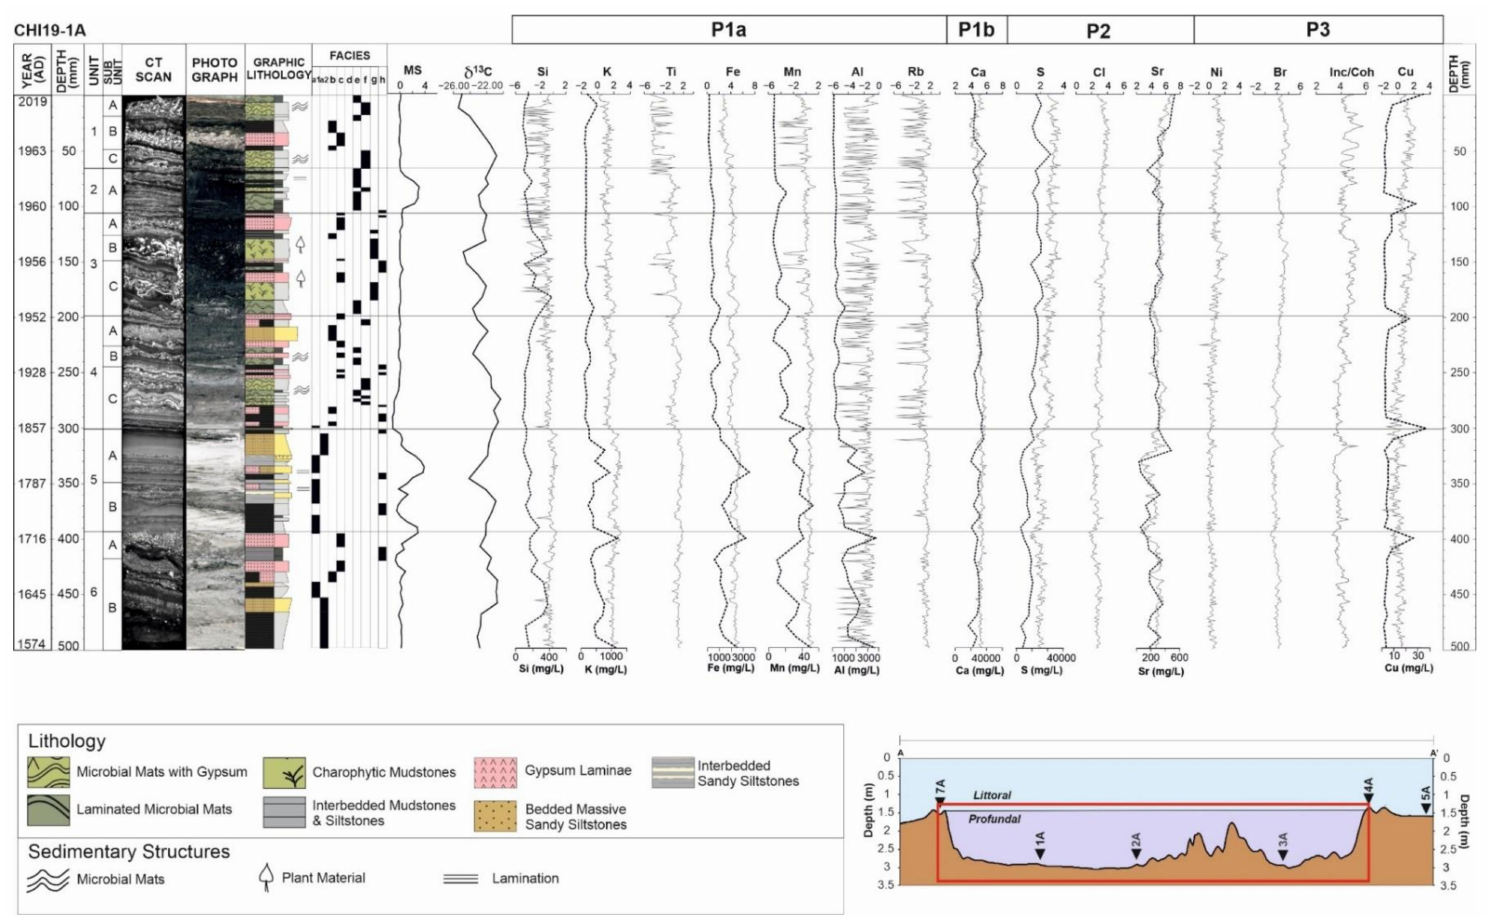
Figure 4. Figure illustrating a geochemical sequence of the profundal depositional sub-environment of the main basin (CHI19-1A) of Lake Chiprana, with elemental XRF data, expressed as transformed counts per second, carbon-13 organic measurements and magnetic susceptibility, expressed as SI, included. Elements are grouped according to the same groupings that are shown on the associated PCA biplot in Figure 3. Facies are described in Table S1. CT data, photographs, graphic lithology and facies are also defined in [30] and their collection methods described. Grey line = XRF, black line = ICP. Element ICP data expressed as mg/L. Inc/Coh = Incoherence/coherence scattering ratio of the X-ray